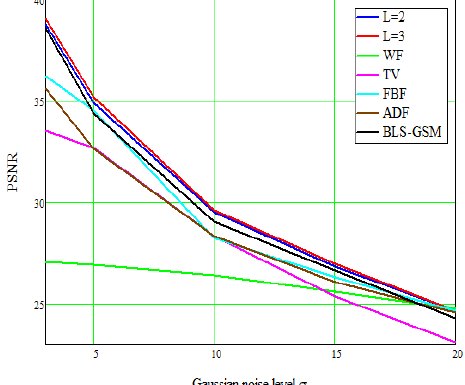
Figure 6. Comparison of measurements SNR of method with different Gaussian noise levels